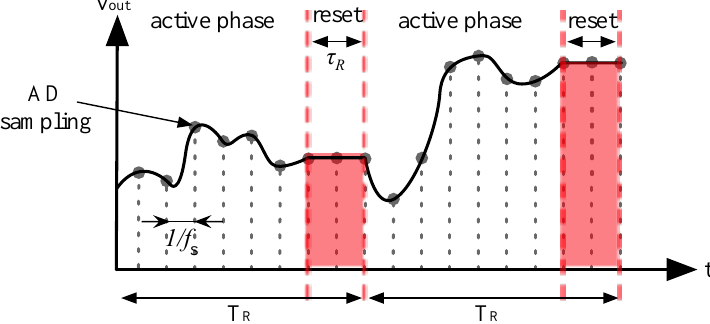
Figure 6. Timing behavior of the system. The frontend resets every period T R = 102.4 μs. During the reset, the output voltage is held at a constant value. AD sampling frequency is n-times higher than the reset frequency.